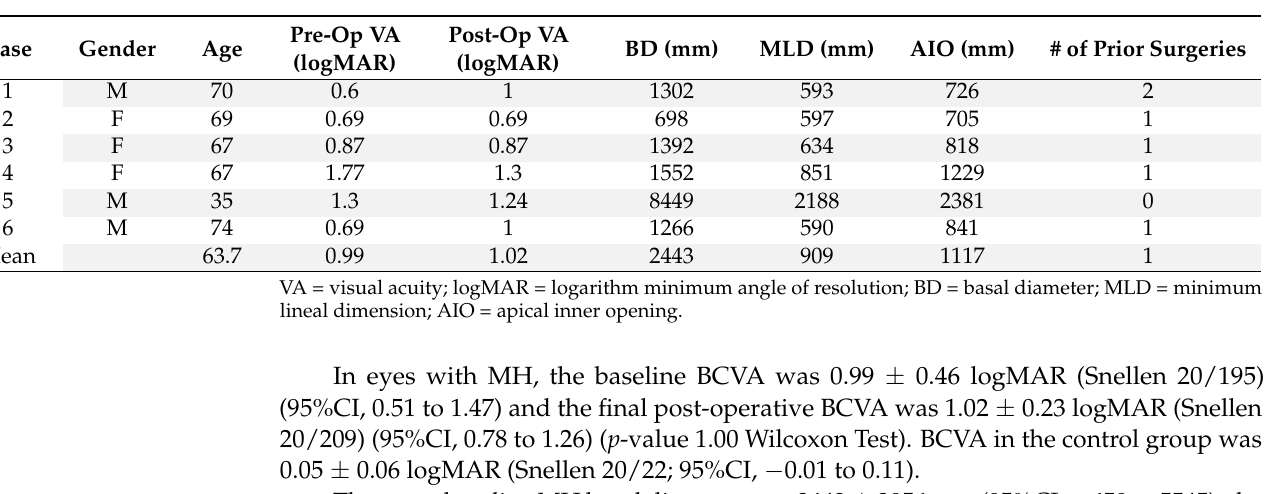
Table 1. Pre-operative characteristics of eyes undergoing autologous retinal transplant.